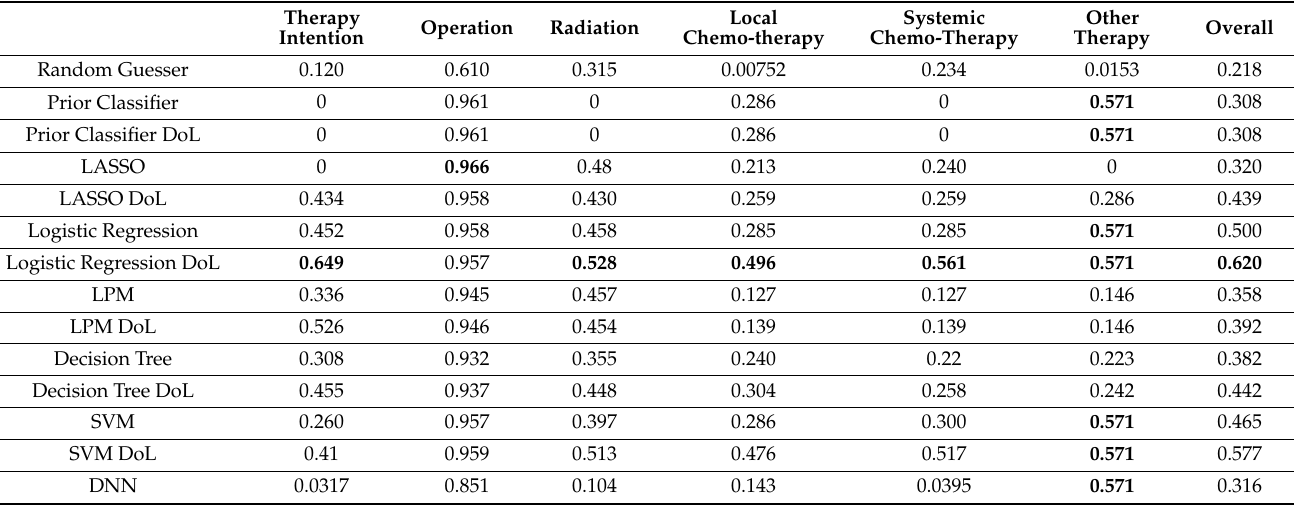
Table 4. Scores of Therapy